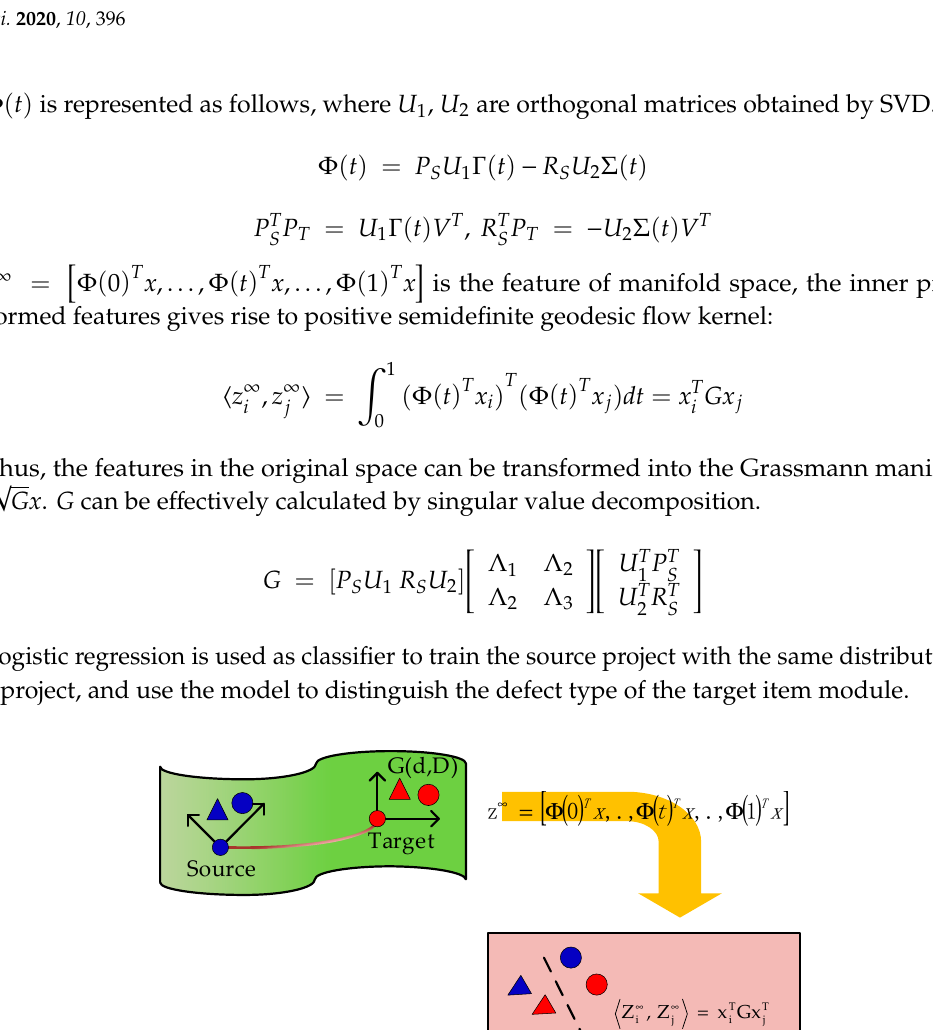
Table 2. Details of projects used in the comparison experiments.